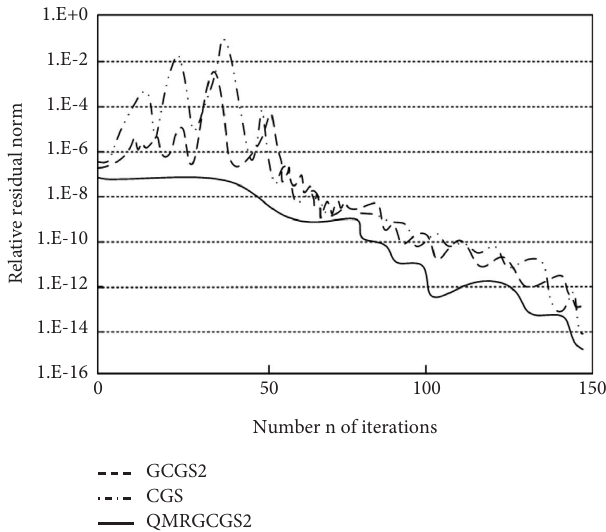
Figure 2: Relative residual norm and iteration step results obtained by 150 steps of three